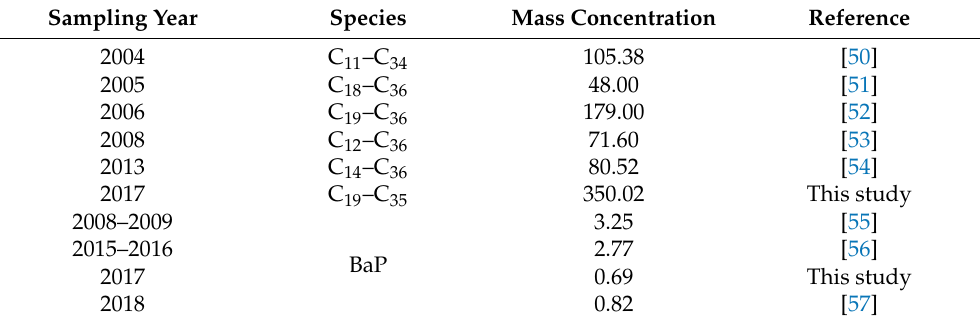
Table 4. Comparison of 17 n − alkanes and BaP mass concentrations in PM 2.5 in Beijing with other studies.